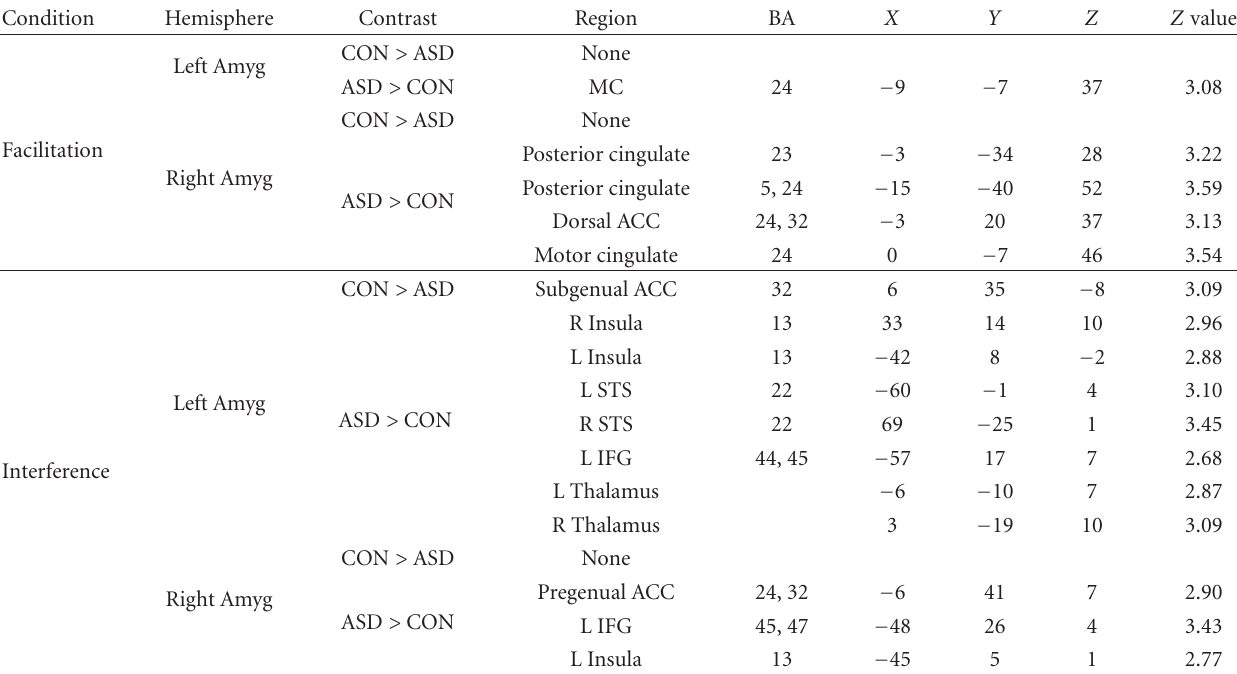
Table 4: Regions showing group di ff erences in left and right amygdala connectivity between control (CON) and ASD children during facilitation (Congruent > Neutral) and interference (Incongruent > Congruent) from eye-gaze ( P < 0 . 05 Monte Carlo corrected).